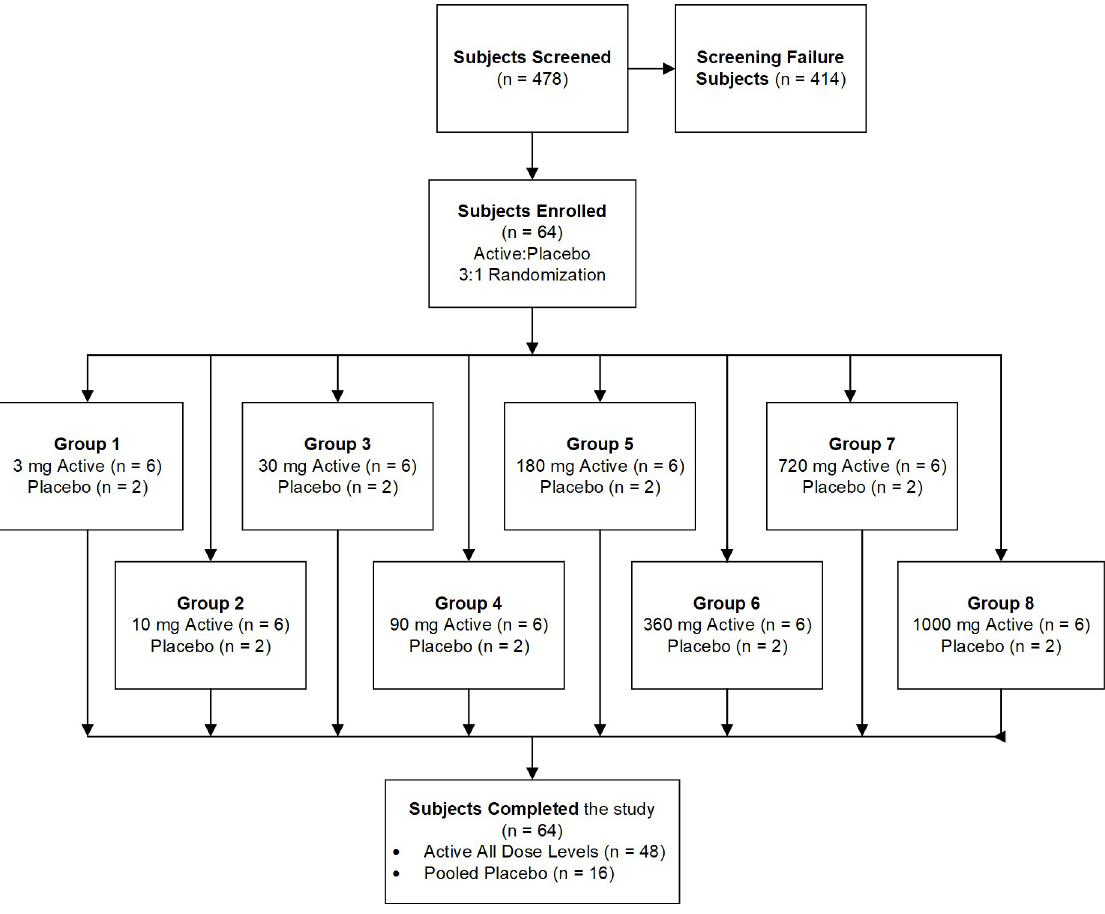
Fig 1. Disposition of subjects. N = number of